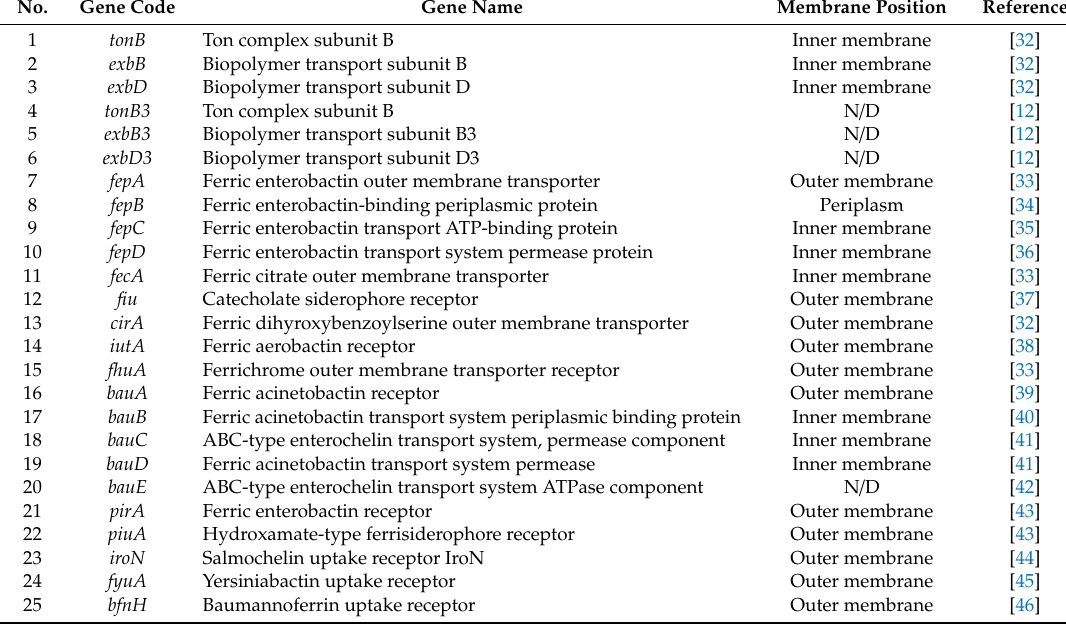
Table 4. Siderophore uptake transporters in E. coli , K. pneumonia and A. baumannii